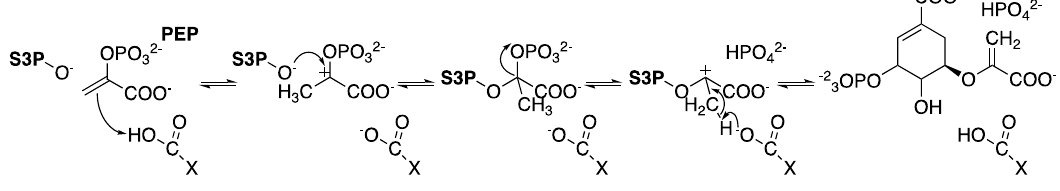
Figure 16. Scheme of the proposed mechanism of catalysis for EPSPS [139].